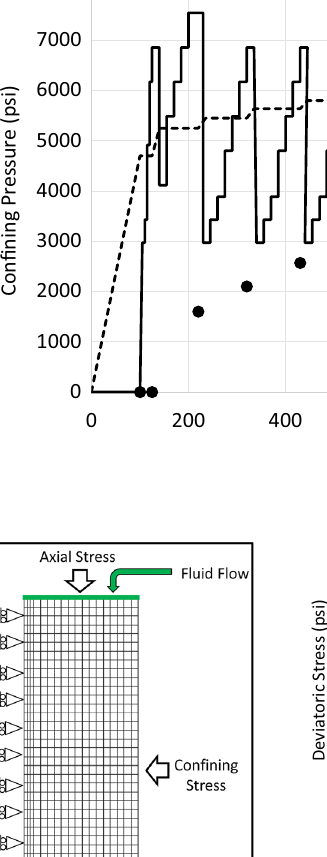
Fig. 11 Sand production test data